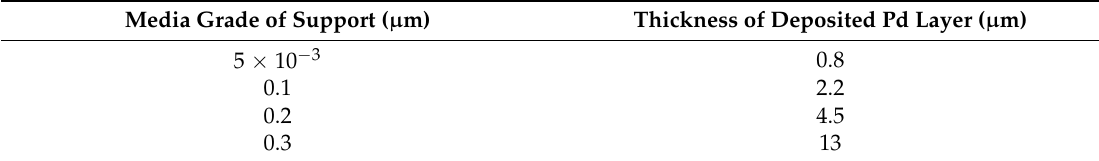
Table 5. Required Pd thickness to cover supports with different pore sizes [109].